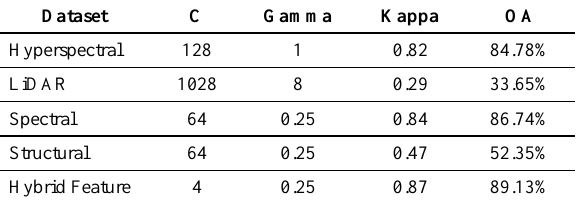
Table 2. Classification accuracy and SVM parameters